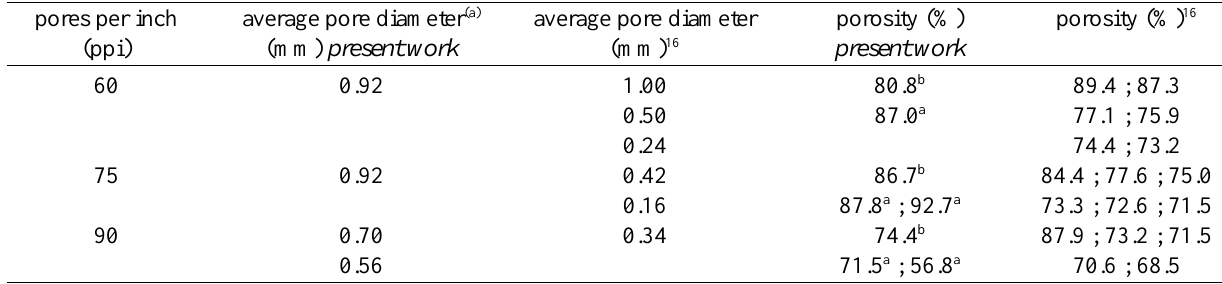
Figure 14. Binary image pattern of the 90 ppi sample. Table 2. Pore size and porosity of the ceramic foam filters. pores per inch average pore diameter (a) average pore